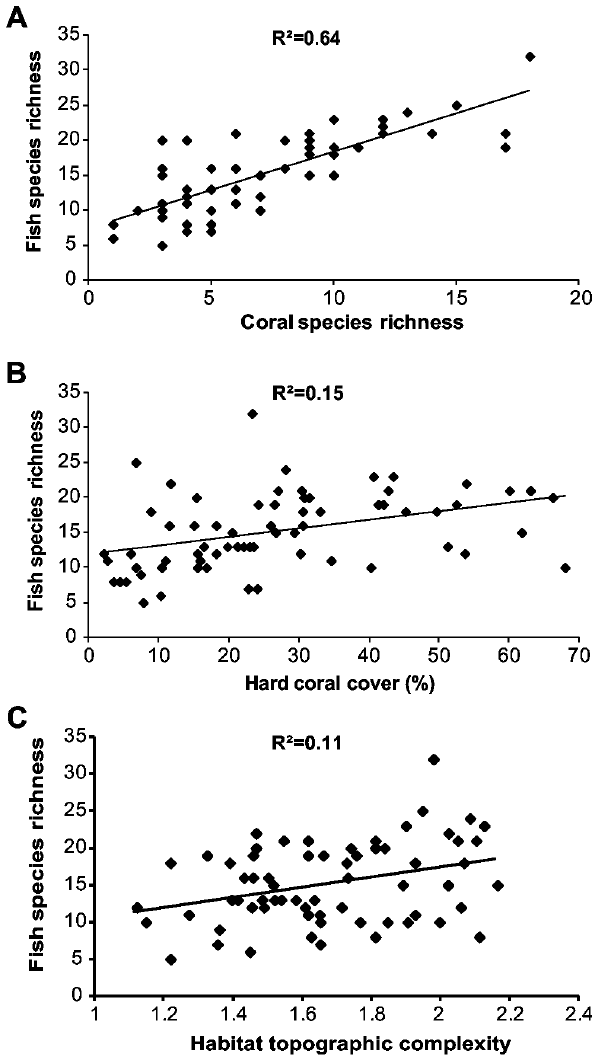
habitat variables in the lagoon of Lizard Island, GBR. All relationships were statistically significant (p<0.05).